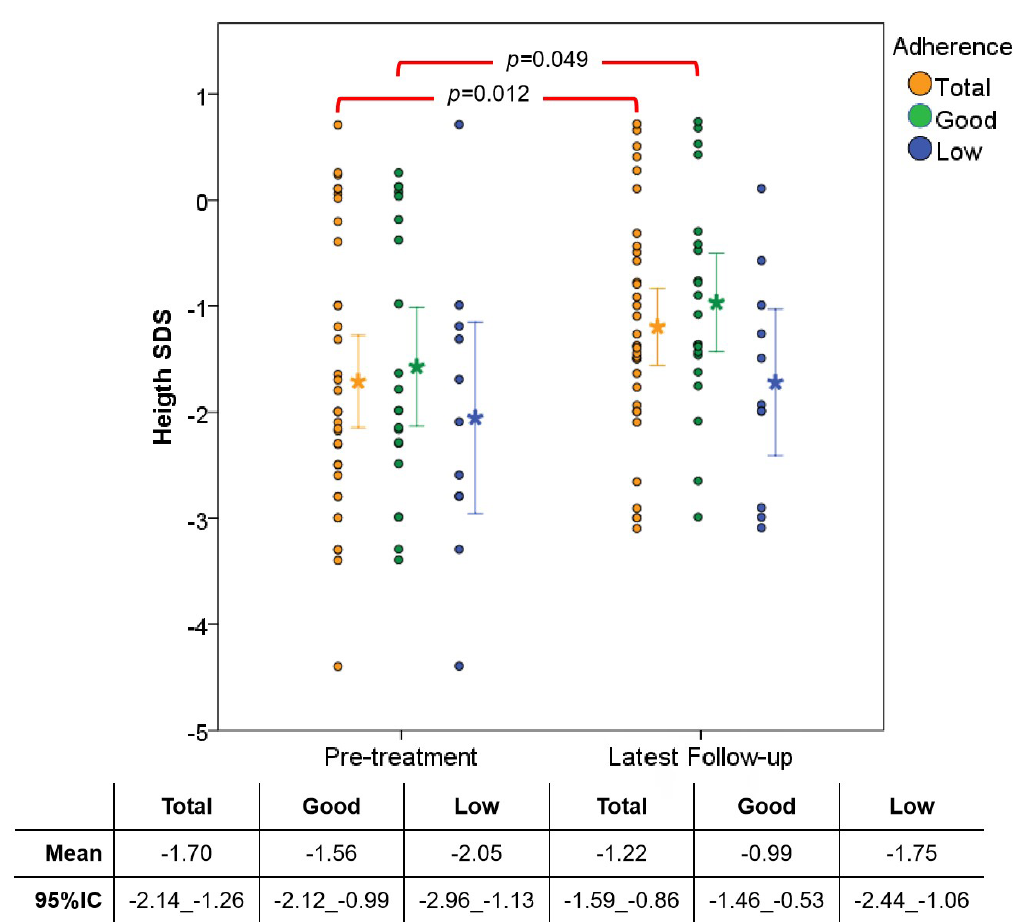
Figure 3. Height (SDS) pretreatment and at latest follow-up stratified according to their adherence. Patients ` height are represented as dots individually on the graph. Means are represented as stars and 95% CI as bars and indicated below. Red braces indicate statistical significance.